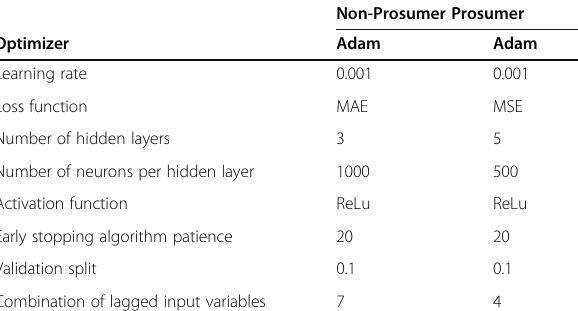
Table 2 (abstract P5). Best neural network parameterization for prosumers and non-prosumers